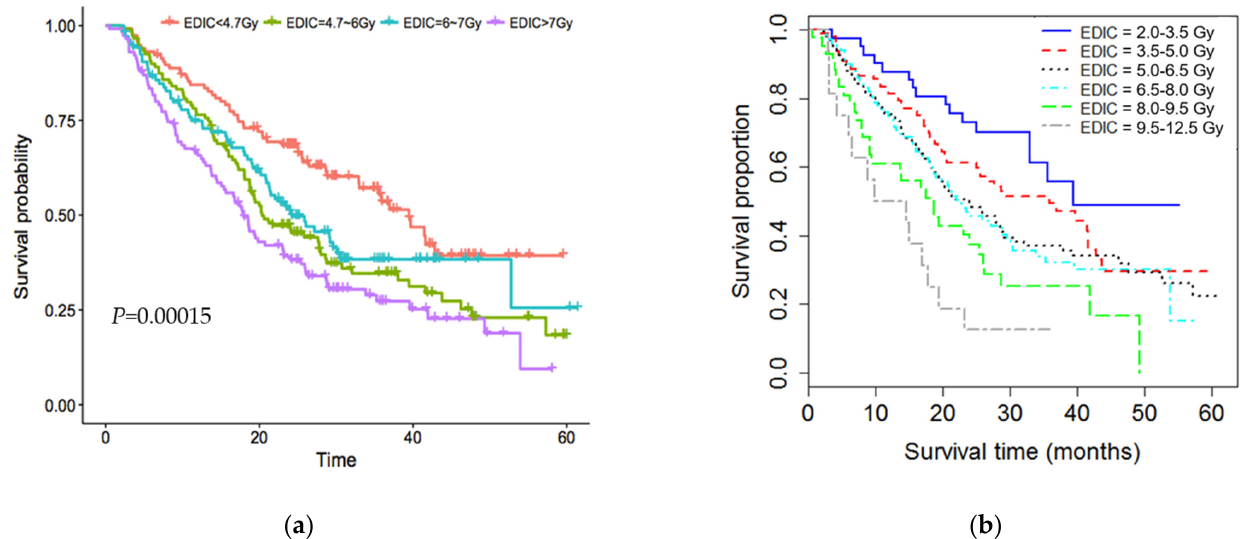
Figure 1. Overall survival curves separated by the effective dose to immune cells (EDIC). ( a ) for patients divided into 4 Figure A1. Computation of the EDIC model. ( a ) Equivalent uniform dose (EUD) to the total blood varies with fraction quartiles according to the EDIC); and ( b ) for patients divided into 6 EDIC groups with a 1.5 Gy dose increment. Survival number ( n ) for various V% (the percentage blood volume irradiated in a specific organ during each fraction), which contains improved significantly with a reduction in the EDIC. However, overall survival (OS) were not significantly different the B % of blood volume that receives irradiation with a mean organ dose (MOD). We have MOD ∗ B % = 3 Gy for this among patients with an EDIC between 6.0 and 8.0 Gy. example organ. V % depends on the cardiac output A %, blood volume B%, blood circulation time T , and beam-on time t for each fraction and can be determined as V % = B% + ( A % − v%) ∗ t / T . We note that when n > 20 and V % > 20%, EUD ~ MOD ∗ B %. Generally, EUD can be approximated as EUD ~ MOD ∗ B % ∗ k 1 ∗ ( n /45) 1/2 for other organs with a smaller V %, where k 1 is a dose effectiveness factor. ( b ) Major organs in the blood circulation system and their esti-mated percentage cardiac output ( A %) and percentage blood volume ( B %) based on an anatomy/physiology text book. For thoracic irradiation, 4 organs/components, including lung, heart, great vessels, and small vessels/capillaries in other organs, contribute to the total blood dose. Because A % ≥ 40% for lung, heart and great vessels, and with t ~1 min and T ~1 min, we have V % = A % ≥ 40%, and the contribution of dose to the blood for these organs can be estimated to be EUD ~ MOD ∗ B